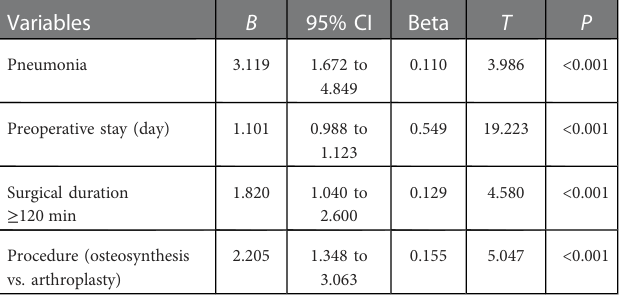
TABLE 3 & Multivariate linear regression analysis showing pneumonia signi fi cantly positively associated with total hospitalization stay, together with other 3 factors.